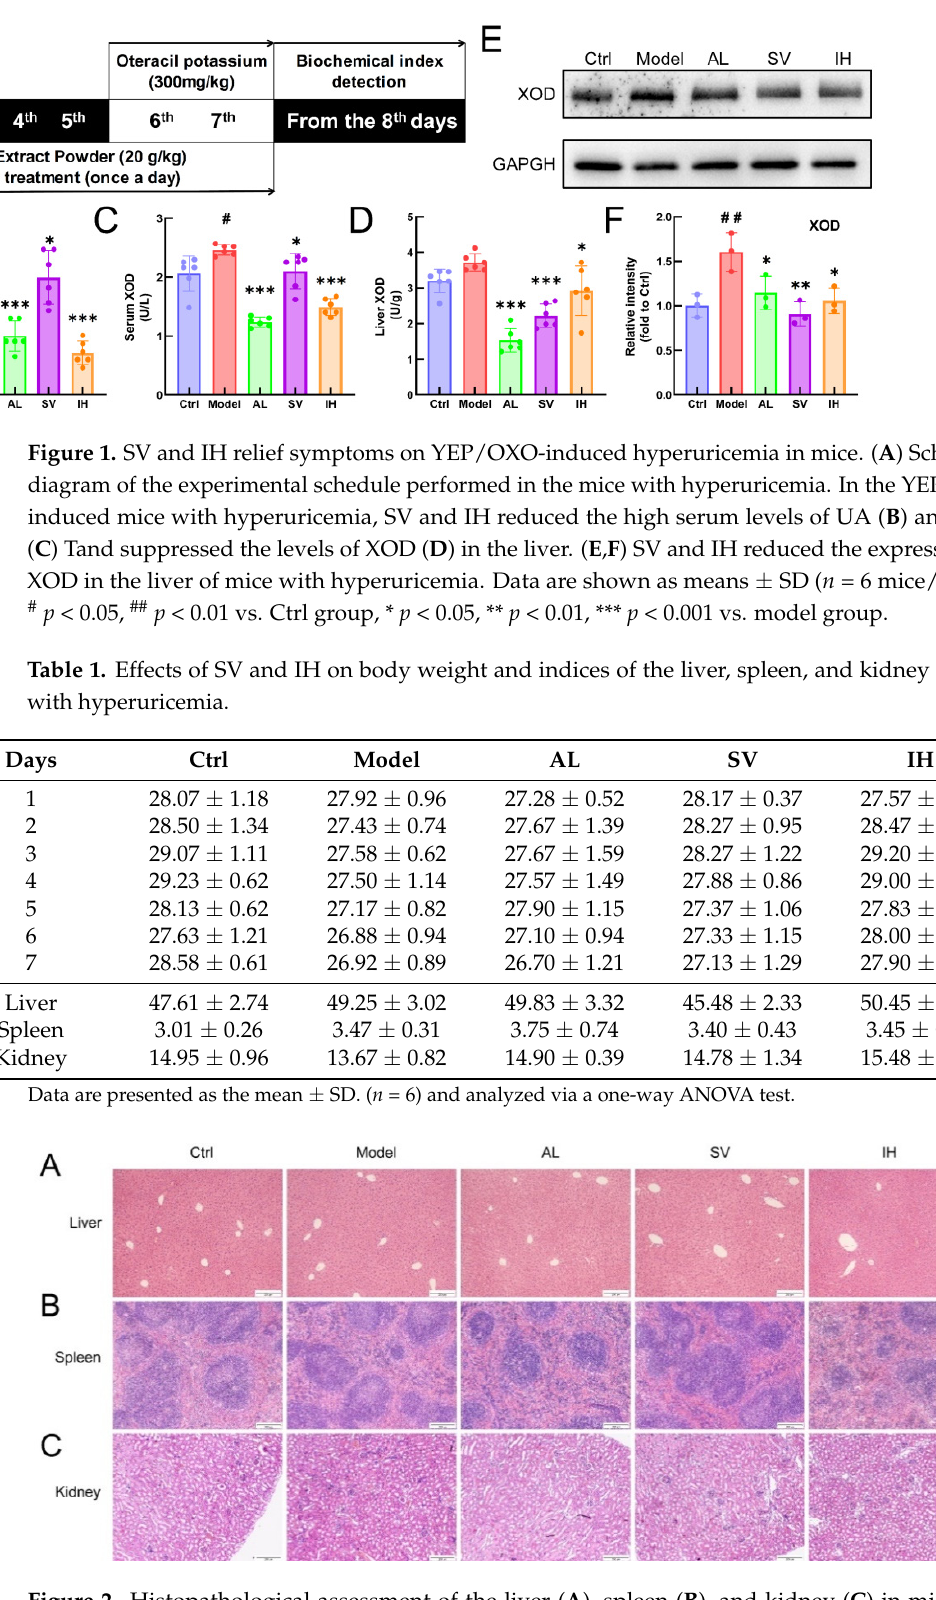
Figure 2. Histopathological assessment of the liver ( A ), spleen ( B ), and kidney ( C ) in mice with hyperuricemia via H&E staining observed with light microscopy (100×). Scale bar, 200 μ m. Compared with the Ctrl mice, a 19.71% enhancement in serum XOD levels (p < 0.05, Figure 1C) was observed in mice with hyperuricemia, which was suppressed by AL up to 49.70% (p < 0.001), by SV up to 14.63% (p < 0.05), and by IH up to 39.39% (p < 0.001) (Figure 1C). Similarly, compared to the vehicle-treated mice with hyperuricemia, AL, SV, and IH resulted in 58.81% (p < 0.001), 40.23% (p < 0.001), and 21.31% (p < 0.05) (Figure 1D) decrements on hepatic XOD, respectively. These results were further confirmed by Western blotting, which showed that the low expression levels of XOD in the liver were in the AL-, SV-, and IH-treated mice with hyperuricemia (p < 0.05, Figure 1E,F). 3.2. SV and IH Relieve the Symptoms in Rats with Acute Gouty Arthritis Compared to the Ctrl rats, MSU significantly enhanced the swelling ratio of the right ankle joints of rats from 8 to 48 h (p < 0.05, Figure 3B), and this swelling was signifi- cantly suppressed by COL administration (p < 0.05, Figure 3B). Similarly, SV suppressed swelling at 24 h (p < 0.01) and 48 h (p < 0.05) (Figure 3B); meanwhile, IH suppressed swelling at 8 h (p < 0.01), 24 h (p < 0.05), and 48 h (p < 0.01) (Figure 3B) after MSU injec- tion. COL, SV, and IH failed to influence the body weights and organ indices of rats with acute gouty arthritis (Table 2). No significant changes were observed in all experimental rats and pathological sections including the liver, spleen, and kidney (Figure 4). Table 2. Effects of SV and IH on body weight and indices of the liver, spleen, and kidney in rats with gouty arthritis. Days